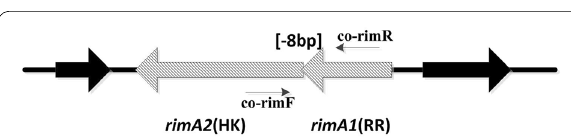
Fig. 2 Organization of the rimA1/A2 genes in the S. rimosus M4018 genome. The orientation of the rimA1/A2 transcription is indicated by arrows. Numbers in square brackets represent the length of intergenic regions in